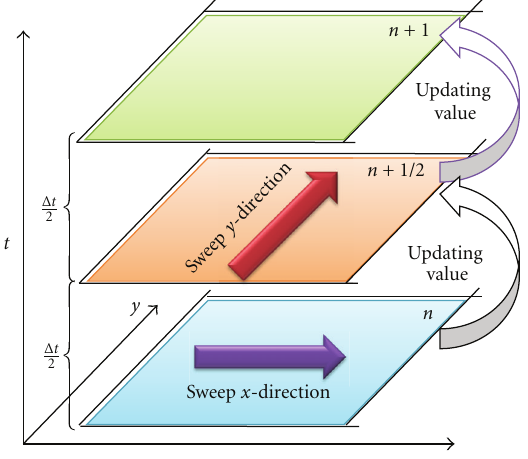
Figure 4: Solving the N-S equations by sweeping.